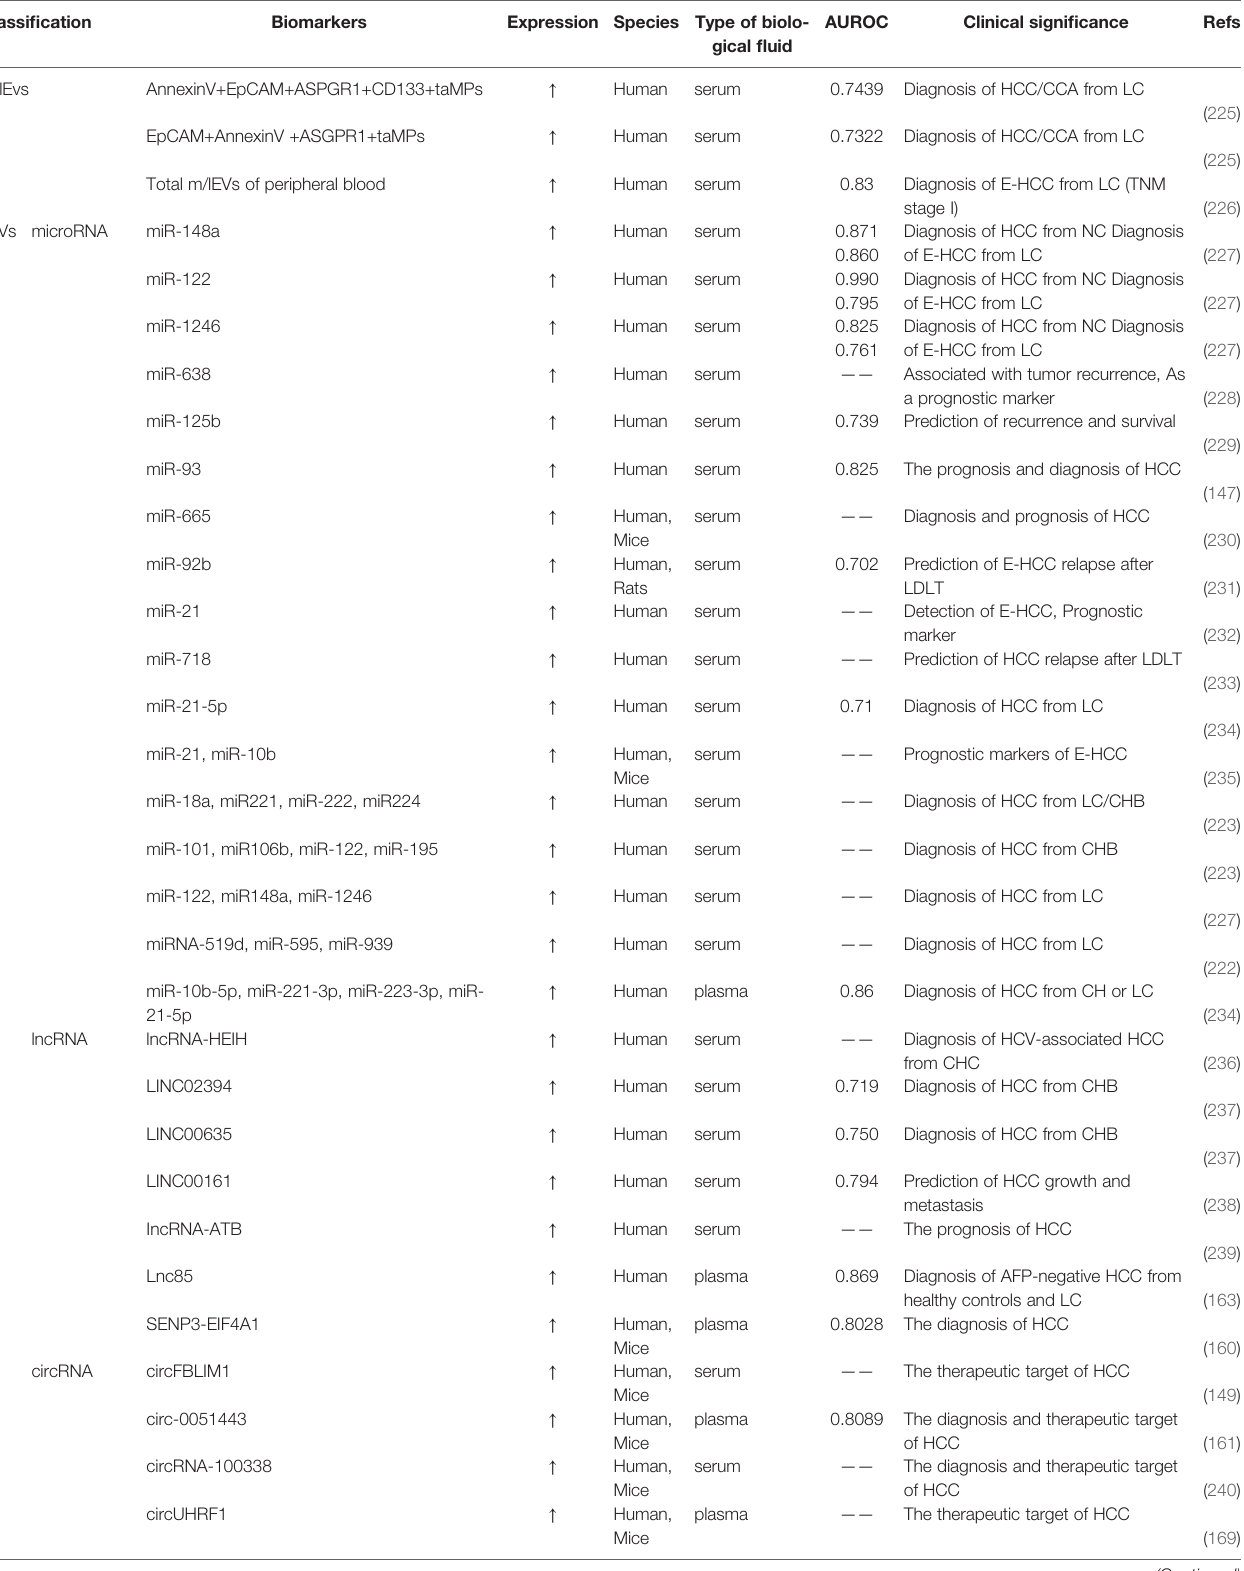
TABLE 3 | EVs as biomarkers for the diagnosis of